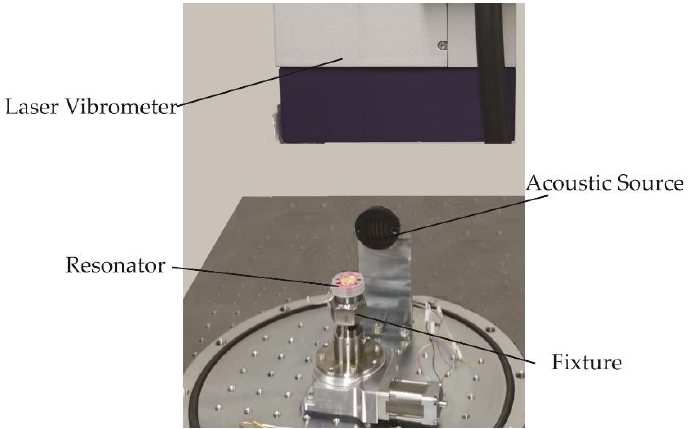
Figure 11. The experimental setup.